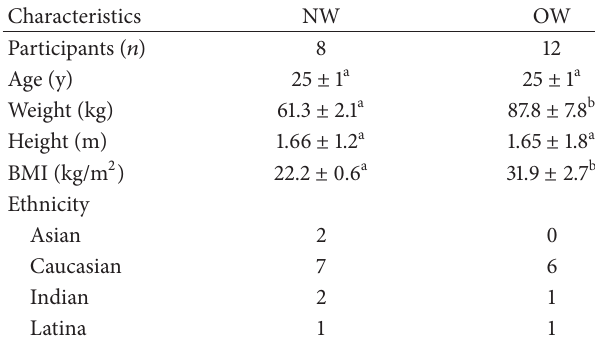
Table 1: Participant characteristics 1 .